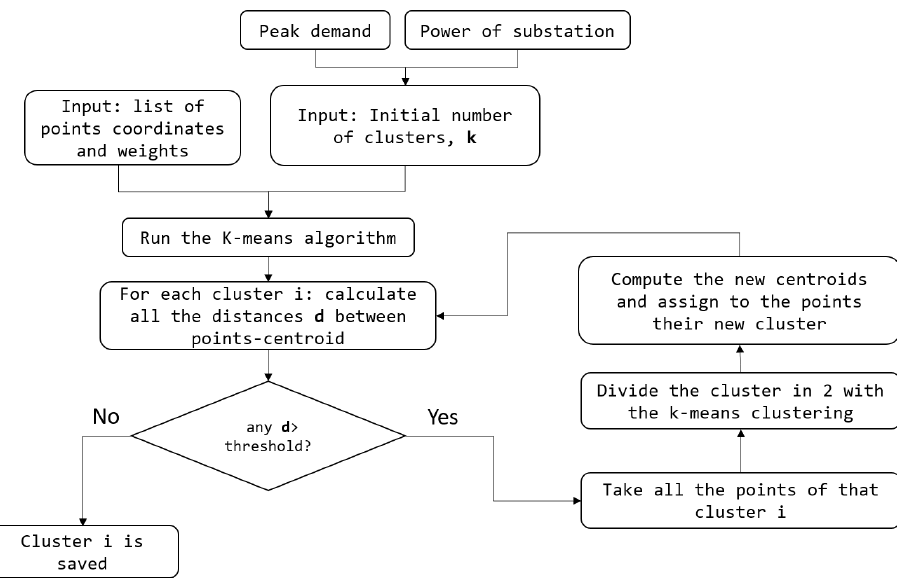
Figure 2. Flow chart of kmeans post